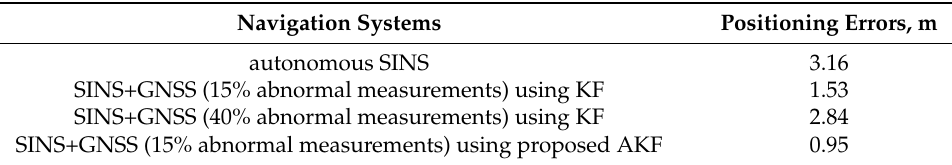
Table 4. Positioning errors of different